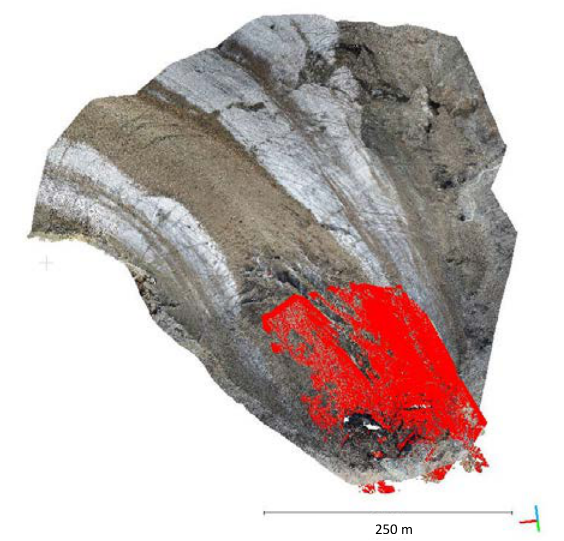
Figure 3. Point cloud of the Forni Glacier composed by data obtained from UAV (in real colour) and terrestrial photogrammetry (in